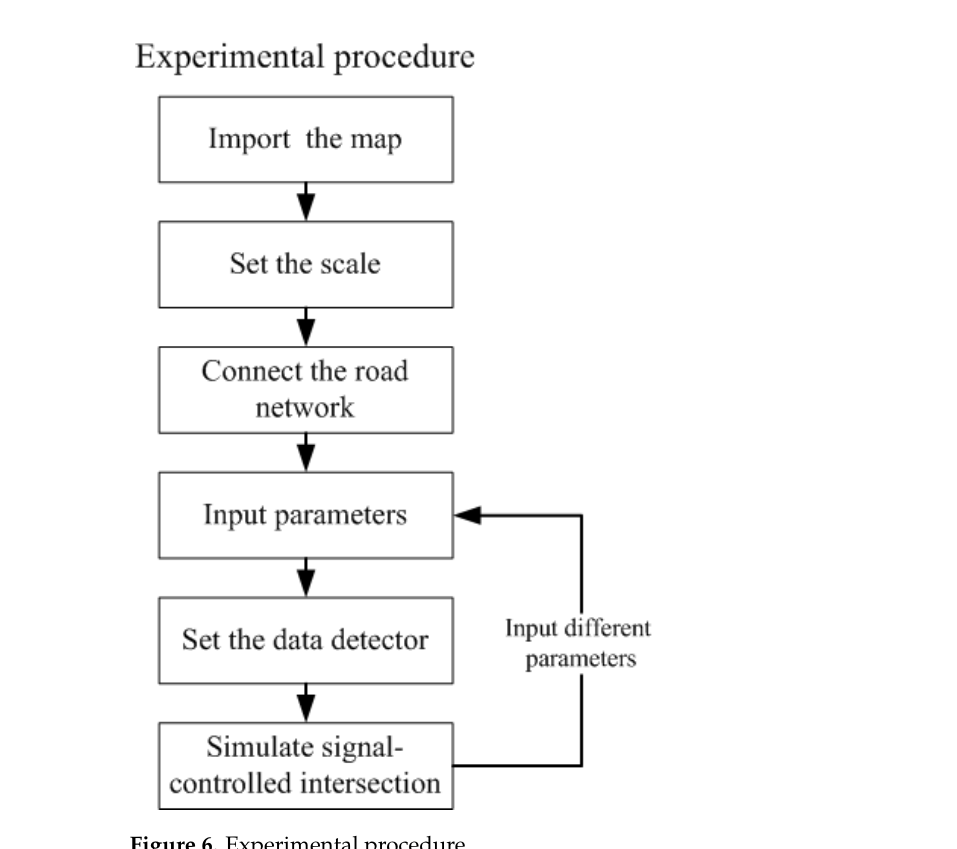
Figure 6. E xperimental procedure. Figure 6. Experimental